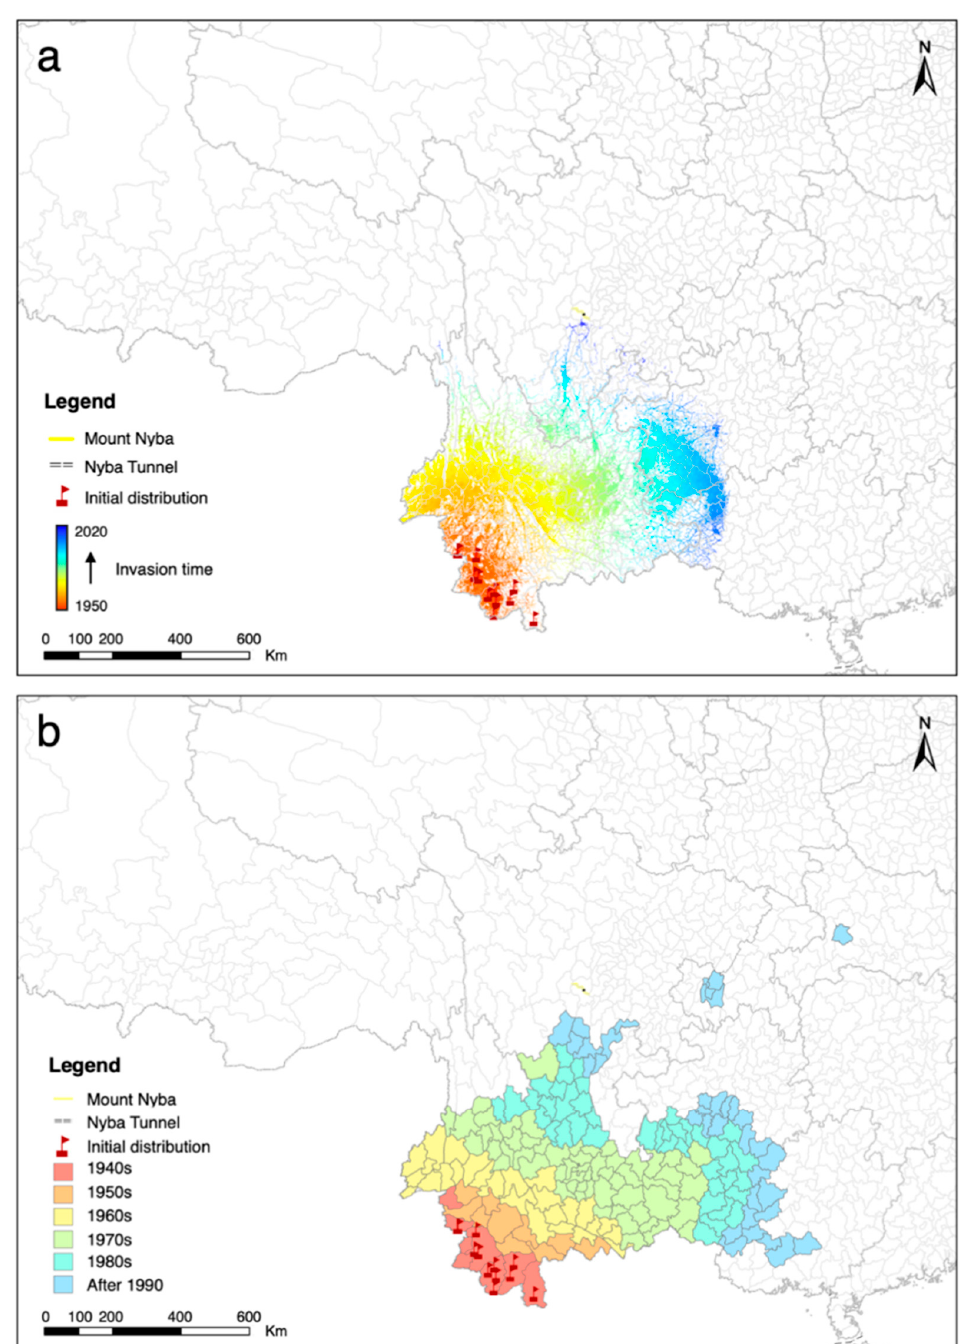
Figure 4. Comparison between estimated and investigated expansion of A. adenophora . ( a ) The spa- tially explicit expansion process of A. adenophora over 70 years (1950–2020) in study area